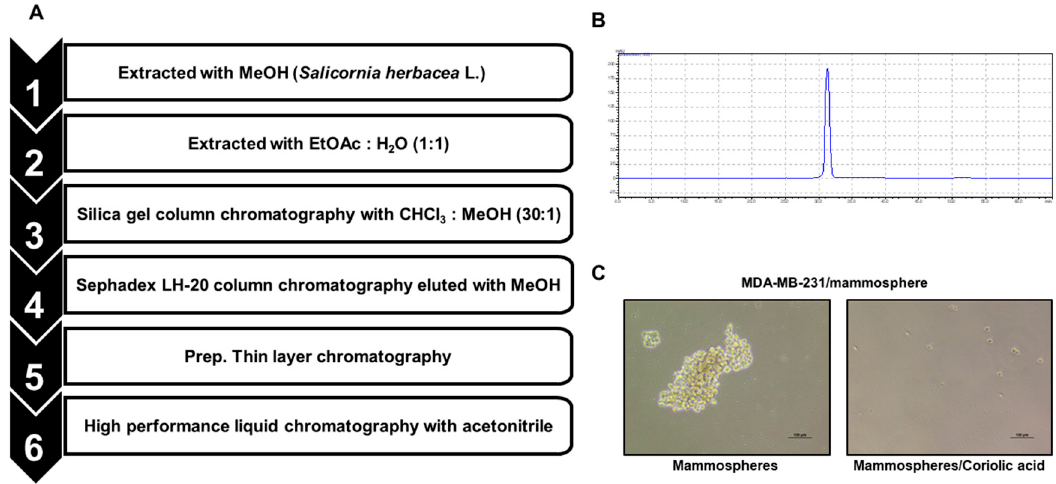
Figure 1. Procedures for the isolation of the breast cancer stem cell (BCSC) inhibitor isolated from S. herbacea L. and the mammosphere formation assay with the purified sample. ( A ) Purification flowchart of the BCSC inhibitor. ( B ) HPLC analysis of BCSC inhibitor derived from S. herbacea L. ( C ) Mammosphere formation assay using the isolated sample. Photos show exemplary mammospheres and were captured by inverted light microscopy (scale bar: 100 µm).